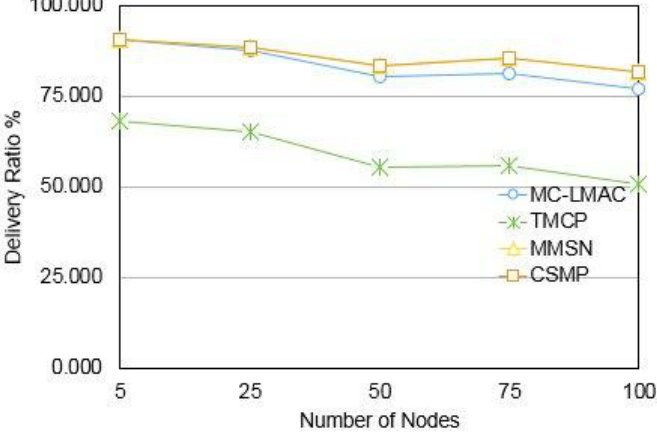
Figure 8. Delivery ratio % vs. number of nodes.